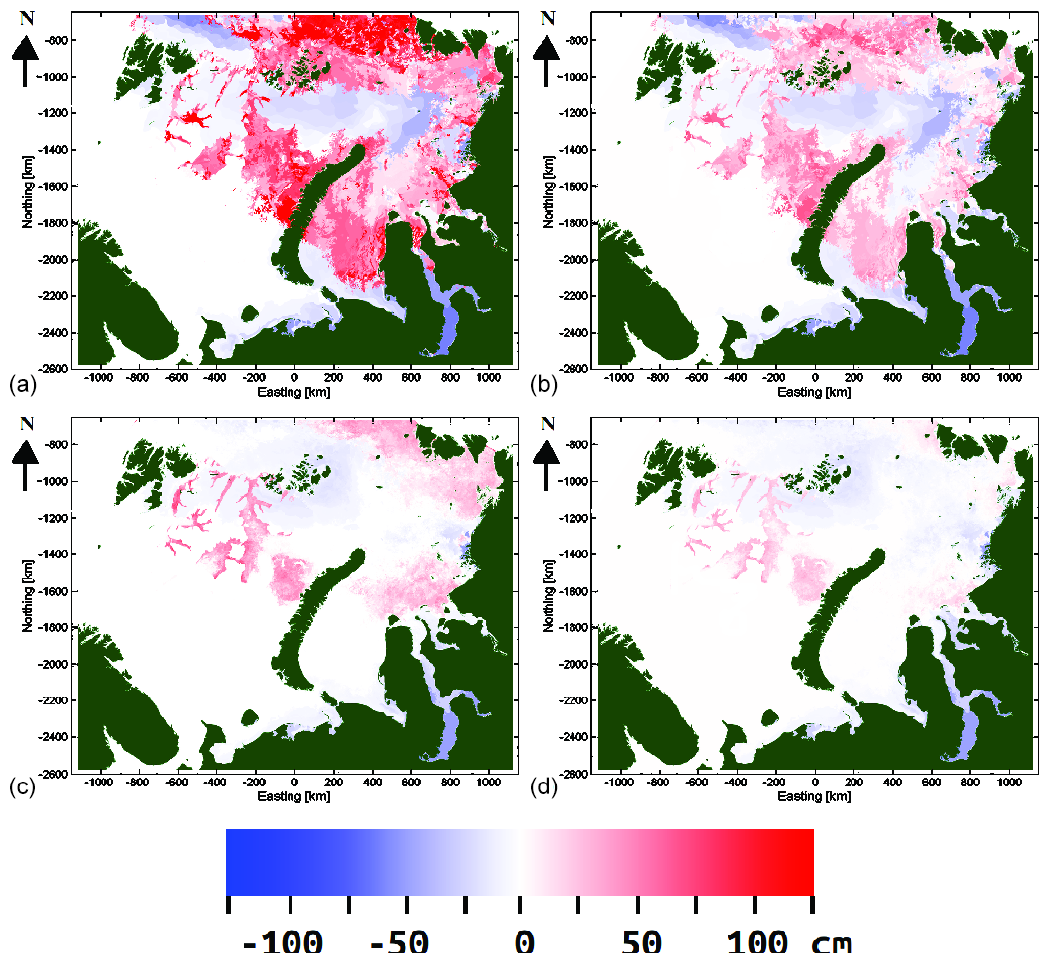
Figure 10. (a) Difference of the proposed (unmapped) SIT for 21 February 2017 and AARI ice chart SIT, (b) difference of the proposed remapped SIT and AARI ice chart SIT for 21 February 2017, (c) average difference of the proposed (unmapped) SIT and the AARI ice chart SIT for the 2017 data, and (d) average difference of the proposed remapped SIT and the AARI ice chart SIT for the 2017 data. Table 8. Monthly averages of estimated SIT (SIT) and remapped SIT (Rem. SIT) for the MODIS daily SIT chart categories. All values are in centimetres. The MODIS SIT categories are 1–30cm (Cat1), 31–50cm (Cat2) and over 50cm